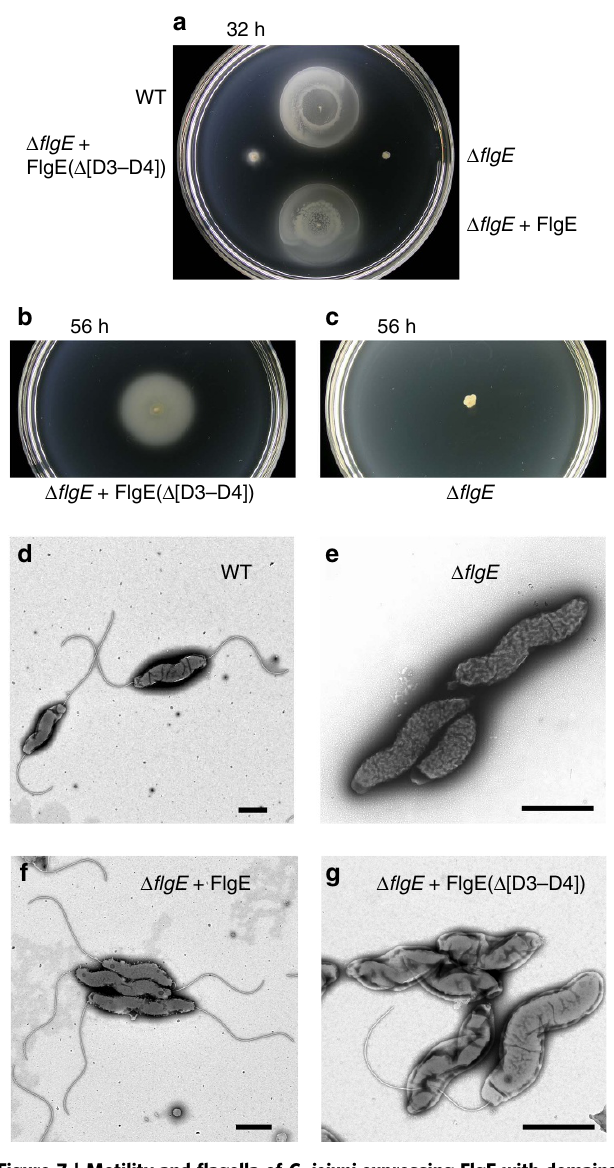
Table 4). The final structure was deposited in Protein Data Bank (PDB-ID: 5JXL).